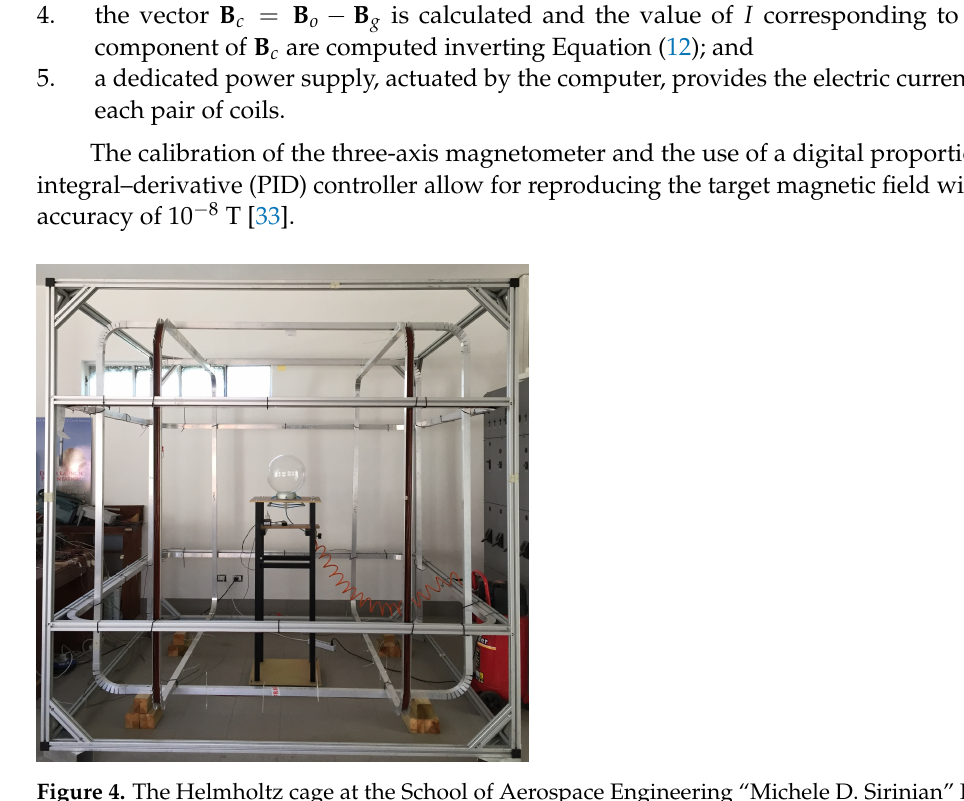
Figure 4. The Helmholtz cage at the School of Aerospace Engineering “Michele D. Sirinian” Flight Mechanics Laboratory, Sapienza University of